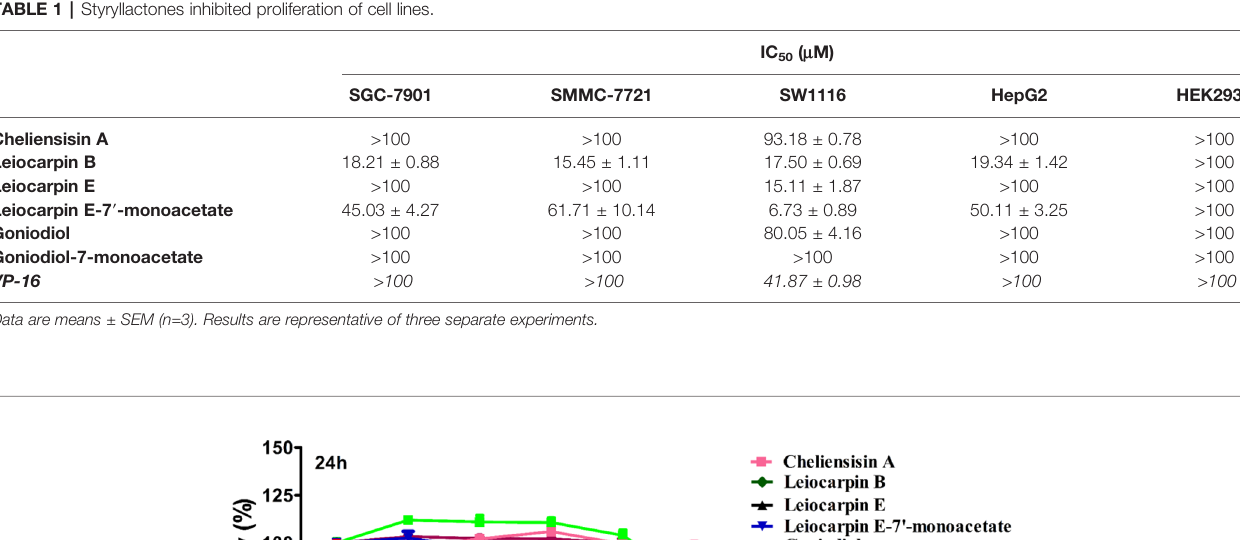
TABLE 1 | Styryllactones inhibited proliferation of cell lines.